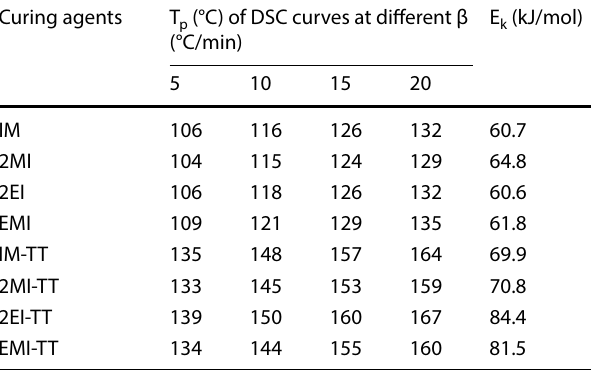
Table 2 The curing kinetic parameters of the EP blends Curing